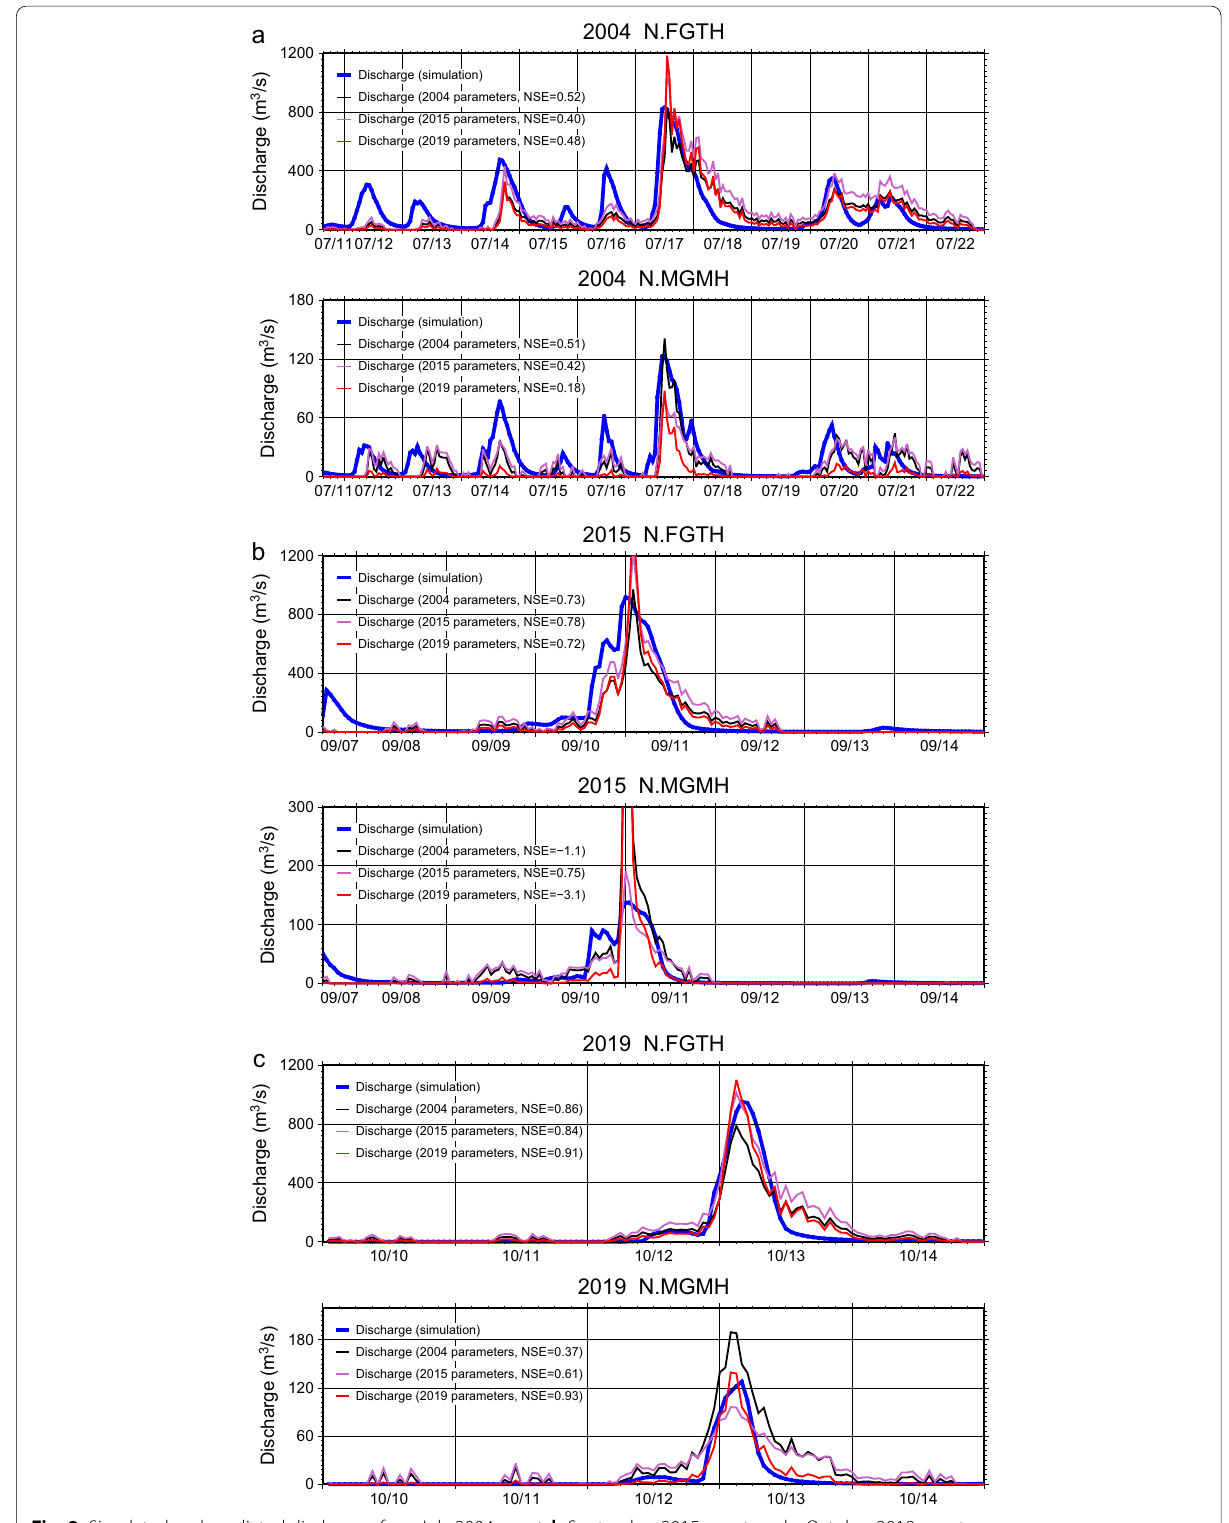
Fig. 9 Simulated and predicted discharges for a July 2004 event, b September 2015 event, and c October 2019